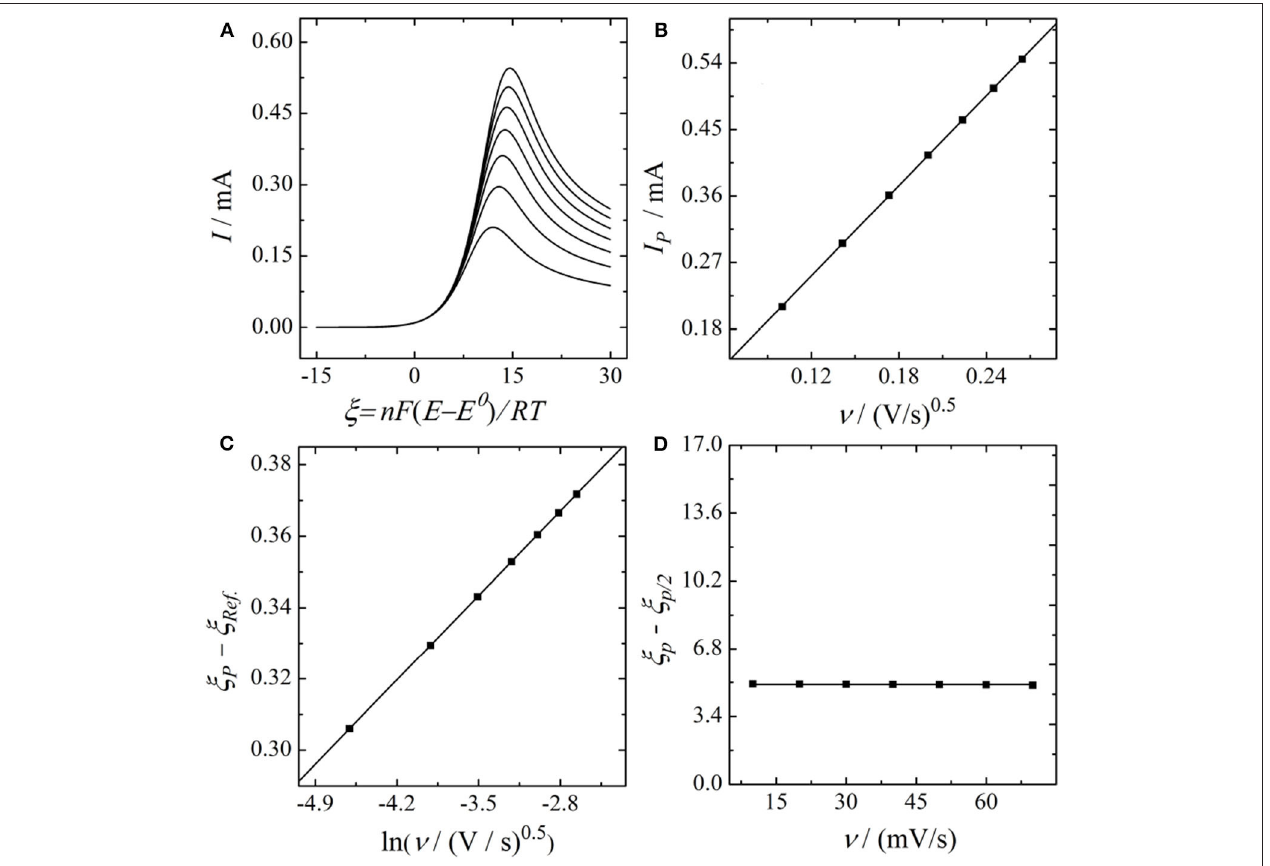
FIGURE 5 | (A) S-LSV curves, (B) Randles-Šev ˇ cík Plot, (C) Matsuda-Ayabe analysis, and (D) peak shape analysis of an electrochemical reaction (the oxidation of VO 2 + with finite kinetics simulated for the set of parameters obtained previously via Tafel analysis and Kouteck-Levich